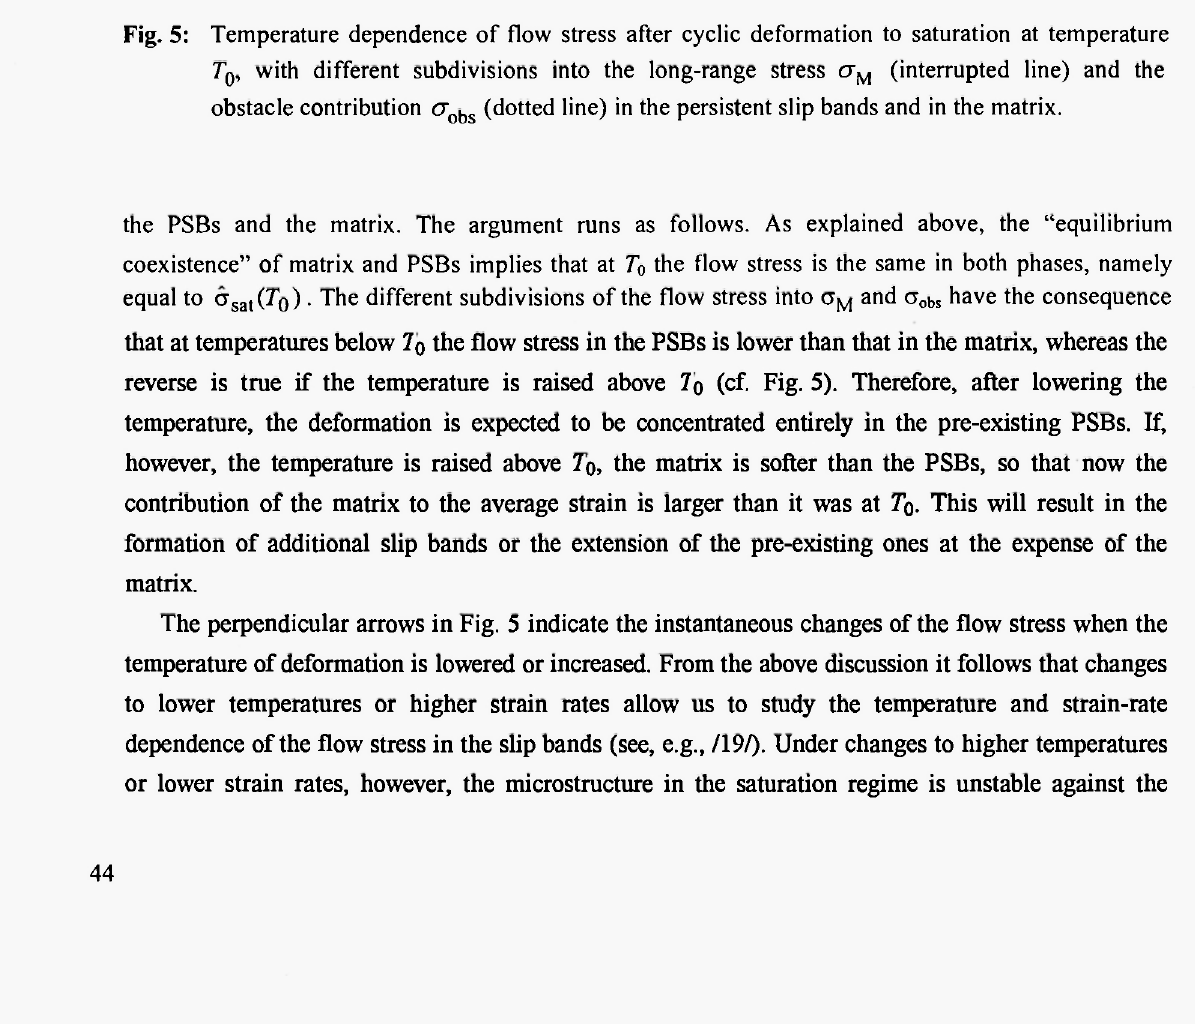
Fig. 5: Temperature dependence of flow stress after cyclic deformation to saturation at temperature T 0 , with different subdivisions into the long-range stress σ Μ (interrupted line) and the obstacle contribution CT obs (dotted line) in the persistent slip bands and in the